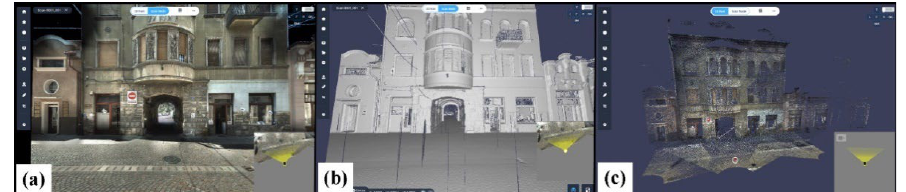
Figure 7. Possibilities of interactive visualization of digital models of the Heyman House (( a ) visualization of the textured surface in 2D Panoramic mode; ( b ) visualization of the polygonal surface in Surface mode; ( c ) visualization of the point cloud in 3D navigation mode ).